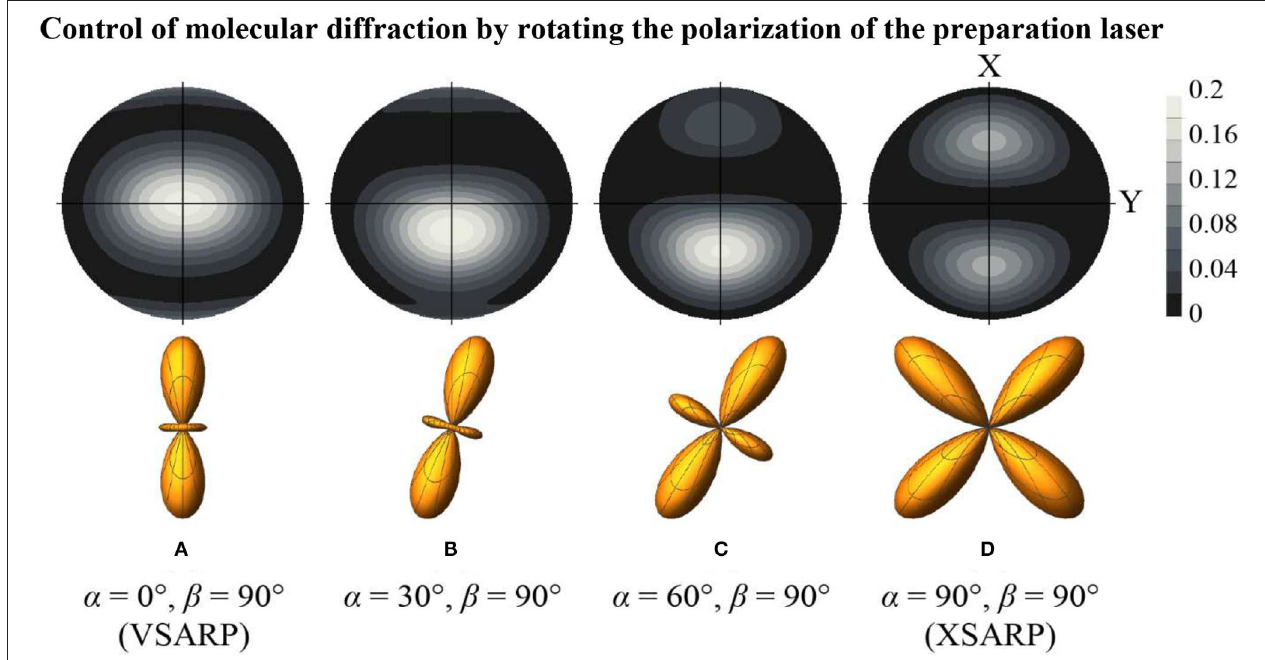
90 ◦ , while = 1, j f 0, m f 0), demonstrating that the maxima of the = = =